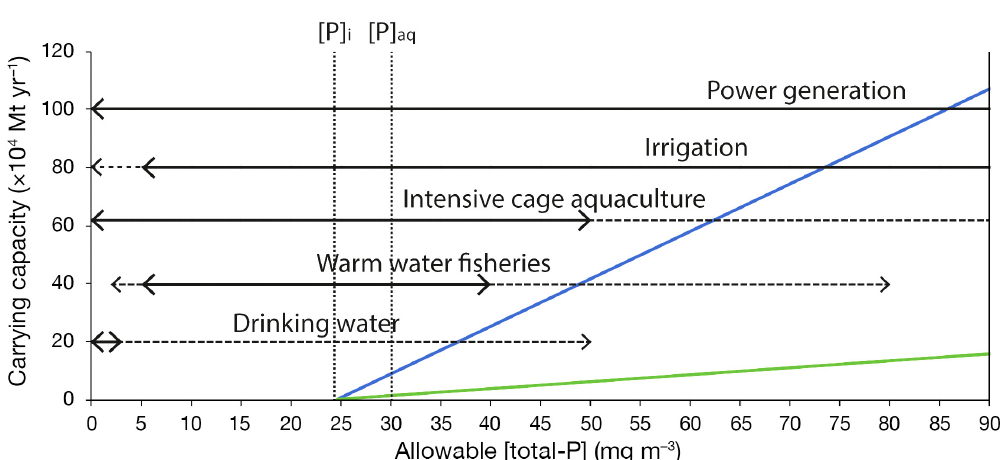
Fig. 7. The carrying capacity of tilapia (blue solid line) and crocodile (green solid line) for different values of the allowable total-P concentration ([P] aq ). Dotted lines indicate the initial total-P concentration of the lake ( [P] i ) and our proposed value for the al- lowable total-P concentration ([P] aq ). Arrows indicate the optimal (solid lines), and allowable (dashed lines) total-P concentration ranges for several lake functions